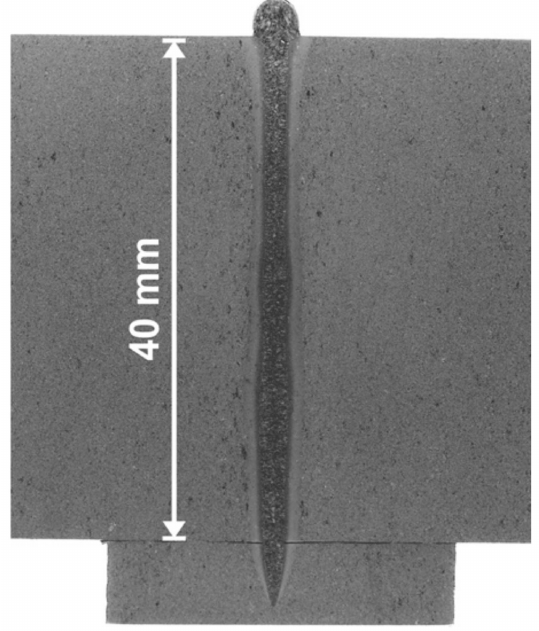
Figure 11. Cross-section of a 40 mm electron beam (EB) weld with an